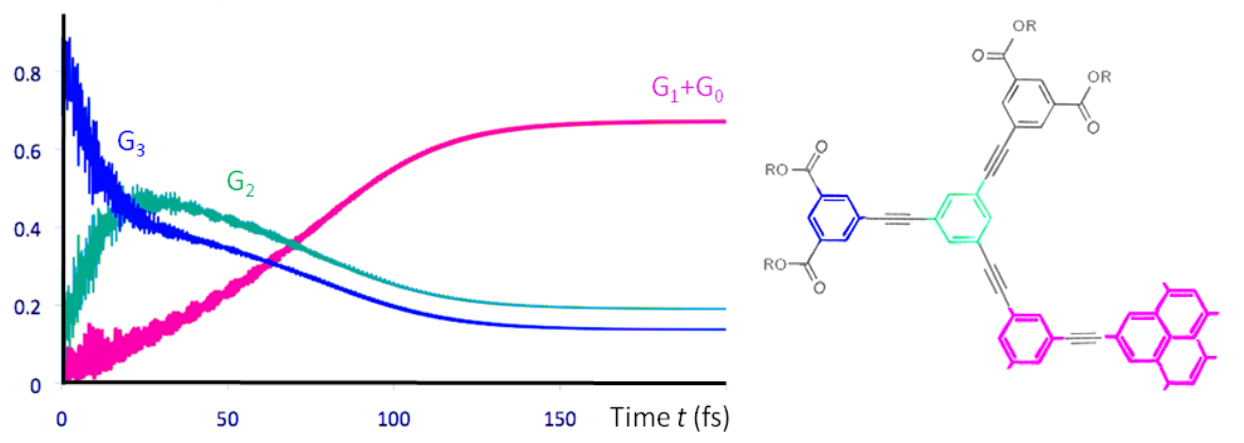
Figure 10. Exciton population density in a third-generation dendrimer plotted against time, following initial photon absorption. Populations are calculated from the density matrix, the energy densities of individual sites then being summed to give the total exciton density per generation (with the core and first generation counted together). One branch of the dendrimer with representative chromophores of different generations is shown on the